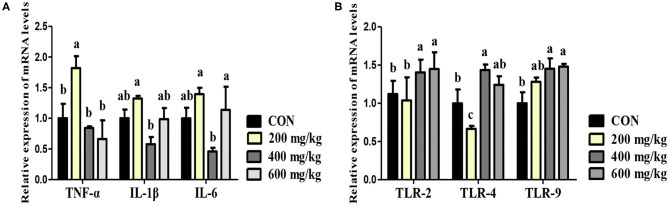
Effects of dietary bacteriophage supplementation on the relative mRNA expression of inflammatory factors (A) and TLRs (B) in jejunal mucosa of weaned piglets fed antibiotic-free diet (n = 5). TNF-α, tumor necrosis factor-α; IL-1β, interleukin-1β; IL-6, interleukin-6; TLR-2, toll like receptor-2; TLR-4, toll like receptor-4; TLR-9, toll like receptor-9. Con: the control diet supplemented with 25 mg/kg quinocetone and 11.25 mg/kg chlortetracycline in the basal diet; Treatments (200, 400, and 600 mg/kg): the treatment diets supplemented with 200, 400, or 600 mg/kg bacteriophage in the basal diet; a,bDifferent letters above bars indicates significant differences (P < 0.05).